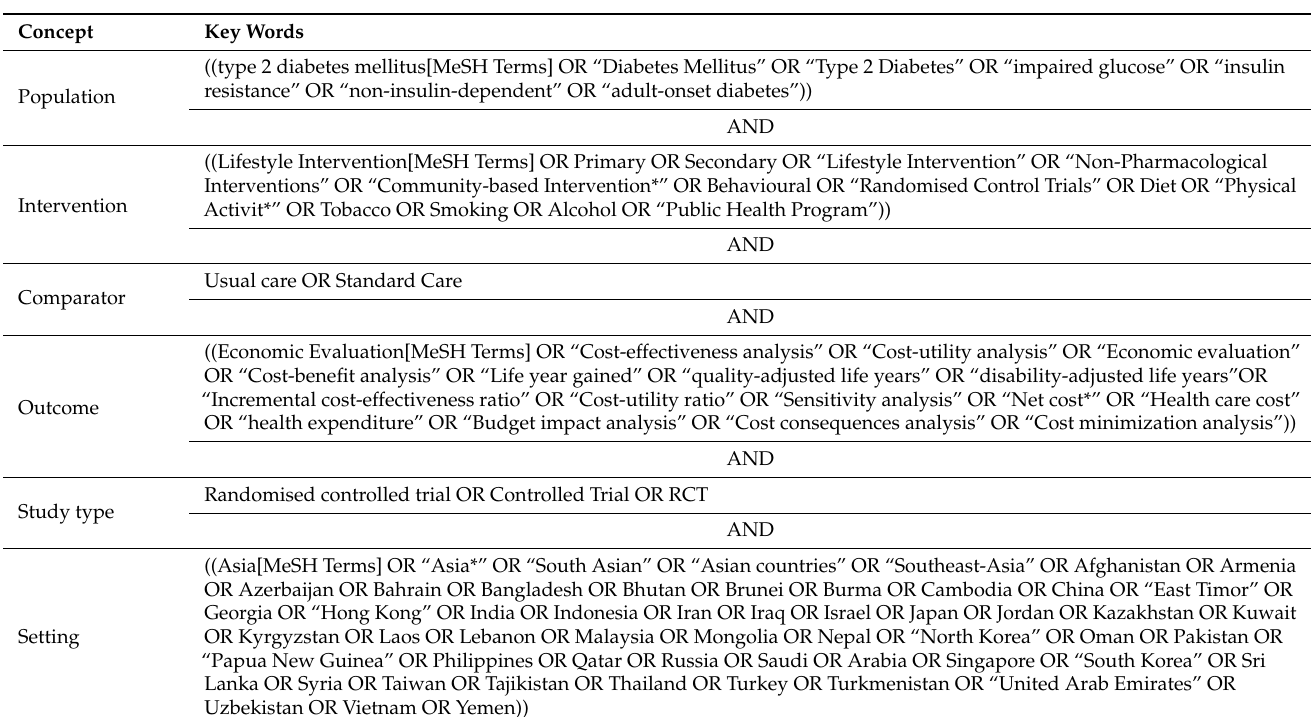
Table 1. Sample search terms for